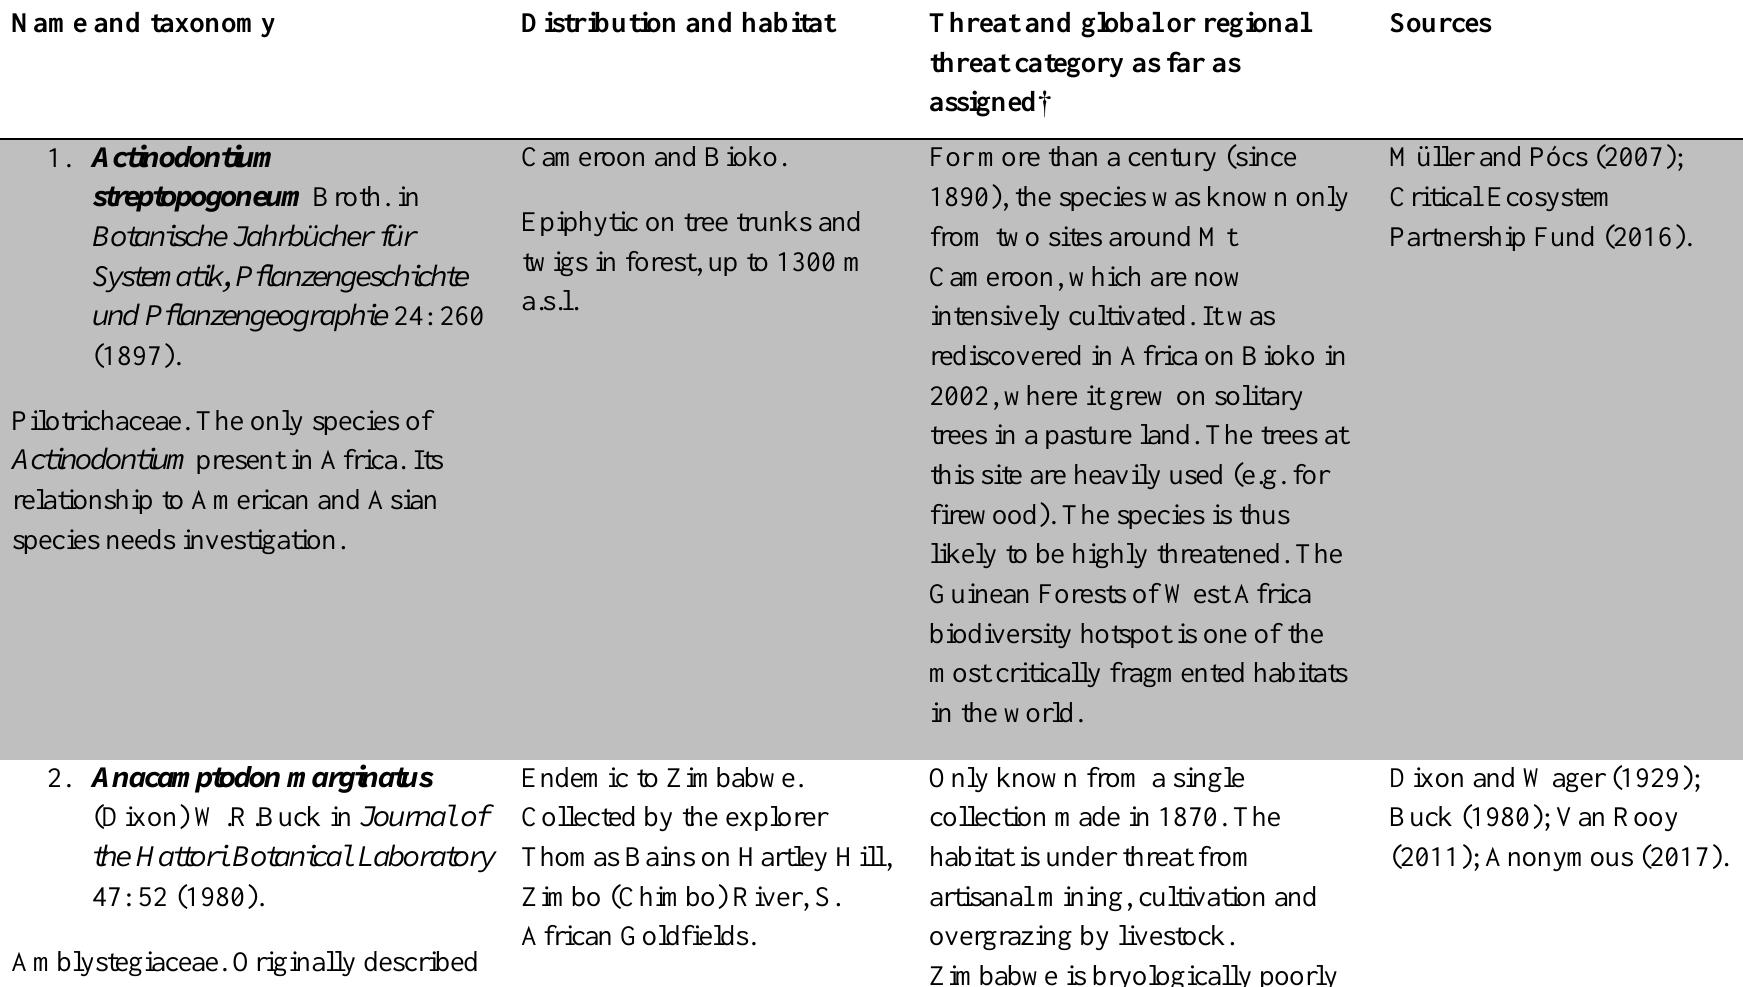
TABLE 1: Fifty lost or threatened bryophytes in sub-Saharan Africa and the East African islands, which served as candidates for the IUCN